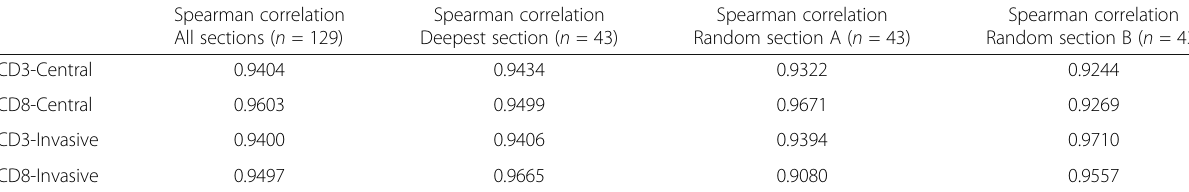
Table 4 Correlation between central and invasive area for estimates of area fraction Spearman correlation Spearman correlation All sections ( n = 129) Deepest section ( n = 43)